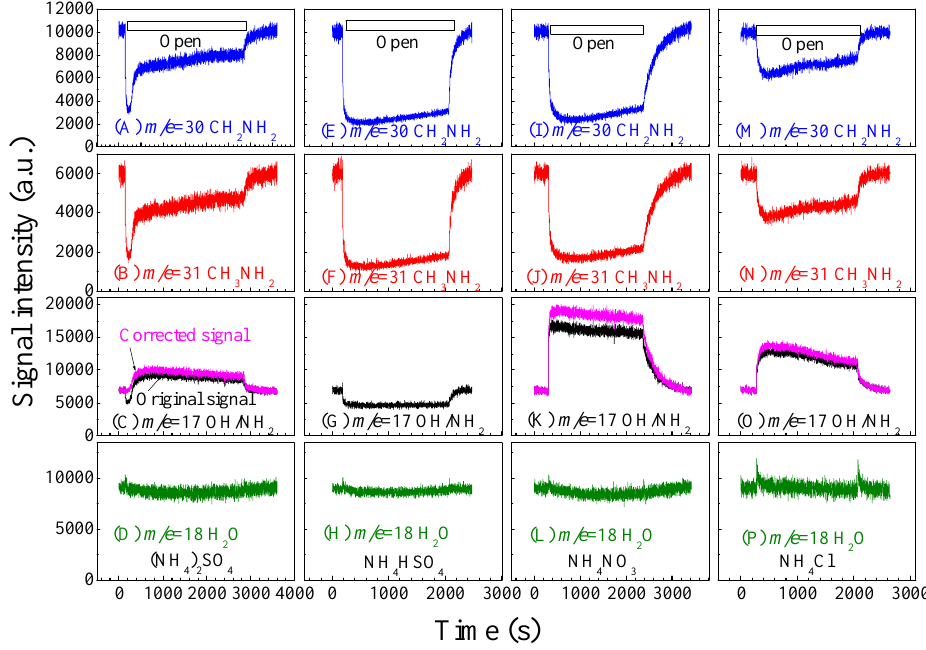
Fig. 1. Mass spectra profiles for uptake of MA onto (A–D) 58.2mg of (NH 4 ) 2 SO 4 , (E–H) 60.5mg NH 4 HSO 4 , (I–L) 59.8 mg NH 4 NO 3 , and (M–P) 63.9mg NH 4 Cl at 298K. The blue curves are for m/e =30; the red curves are for m/e =31; the black and purple curves are for m/e =17; and the olive curves are for m/e